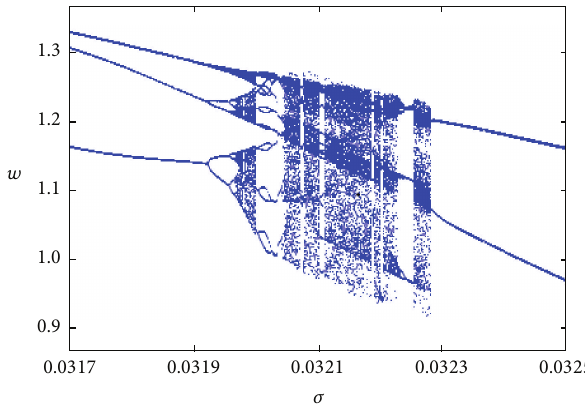
Figure 4: Bifurcation diagram for 0.0315 < 𝜎 < 0.0325